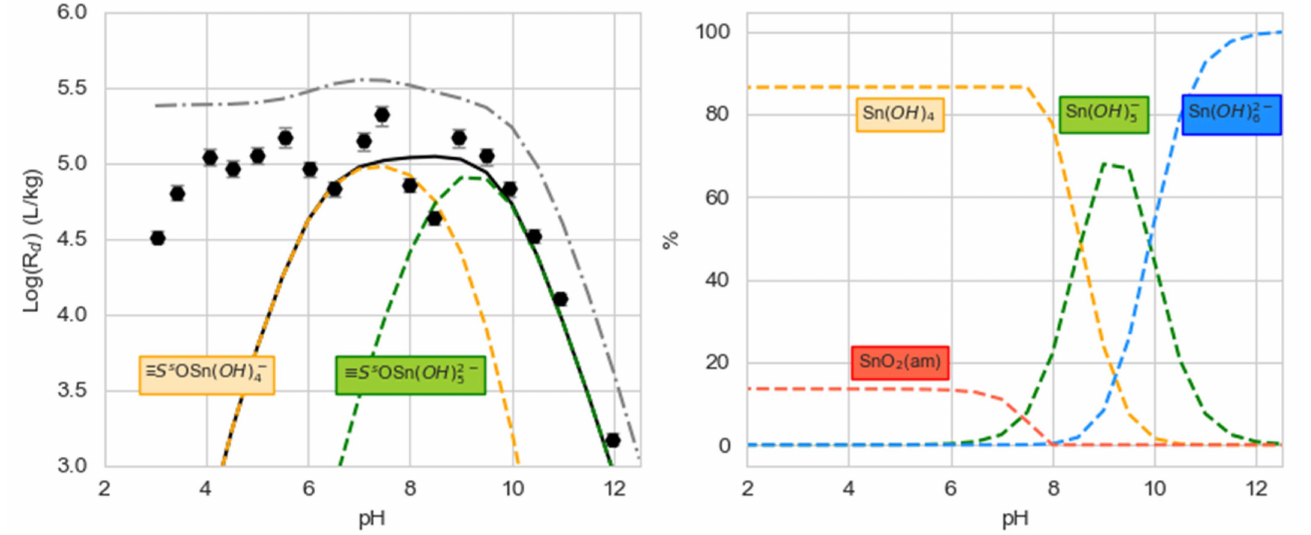
Figure 1. Left : Sorption edge of Sn(IV) on IdP in 0.017 M NaClO 4 at initial Sn(IV) concentration of (6.8 ± 0.4) × 10 − 8 mol/L and solid/liquid ratio of 0.65 ± 0.02 g/L. Black markers = experimental points. Grey dashed line = 2SPNE SC model with Sn(IV) surface complexation constants and hydrolysis constants reported by Bradbury and Baeyens [10] (Table 4). Black solid line = 2SPNE SC model with log K 3 , log K 4 (Table 5) and ≡ S s OH (Table 3) and hydrolysis constants from Thermochimie V10a (Table 4). Dotted coloured lines = contribution of the different surface complexes. Right :